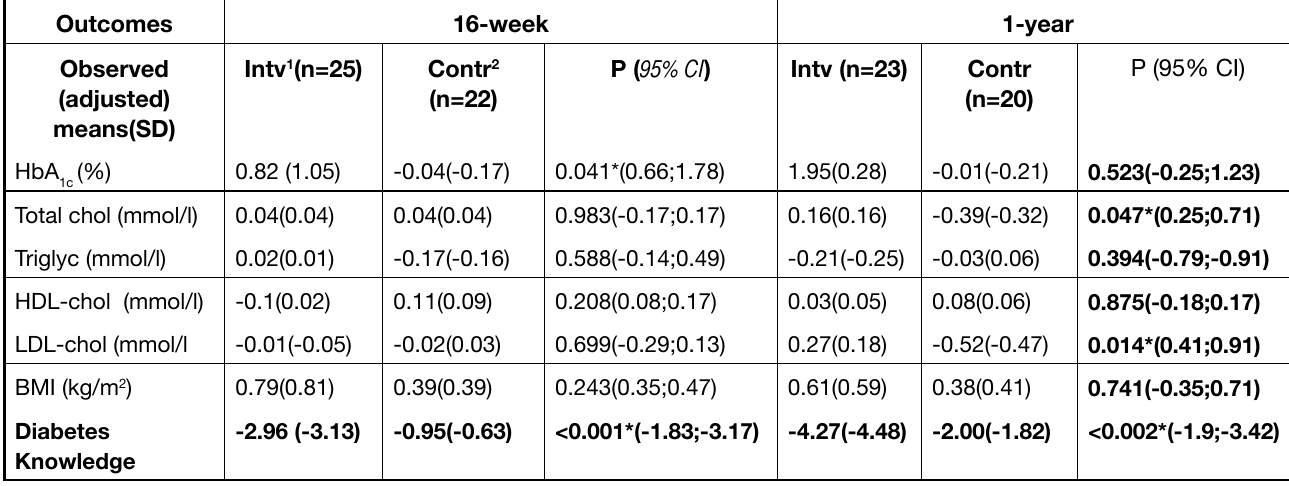
Table 2: comparison between groups with respect to the change in the means from baseline in primary and secondary